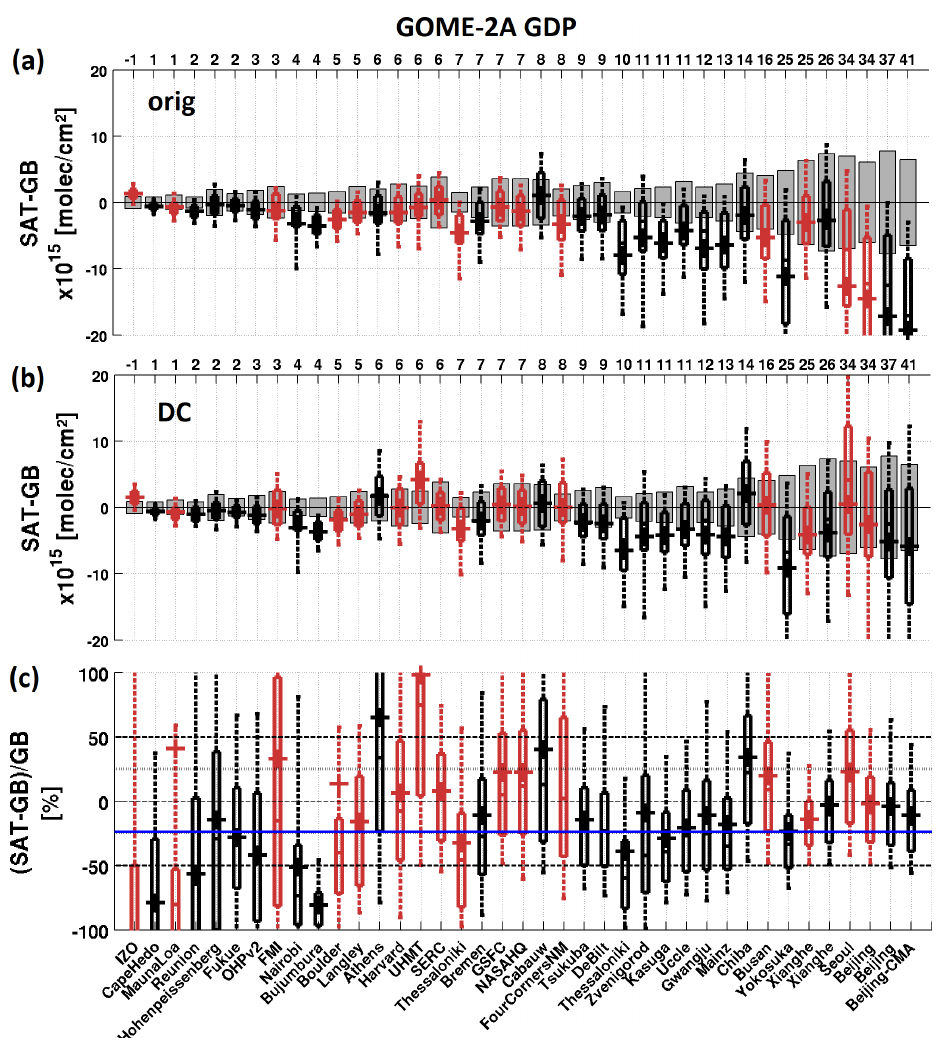
Figure 15. Box-and-whisker plot of the daily GOME-2A GDP 4.8 biases for each station (a) for the original data and (b, c) when correcting for the dilution effect, in absolute and relative values. MAX-DOAS stations are presented in black; direct sun stations in dark red. The stations are ordered by increasing values of the ground-based VCDtropo for the satellite overpasses coincidences, and corresponding values are given on the upper horizontal axis. The box-and-whisker plots are defined as in Fig. 7. In panels (a, b) , grey bars are the ± comparison error, calculated by adding in quadrature the satellite and ground-based VCDtropo